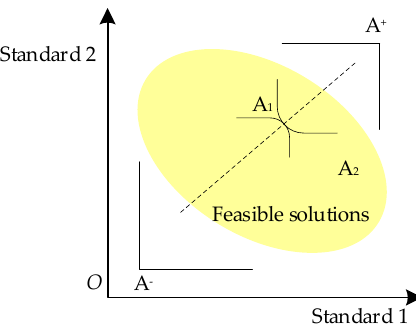
Figure 3. Decision diagram of the TOPSIS method.